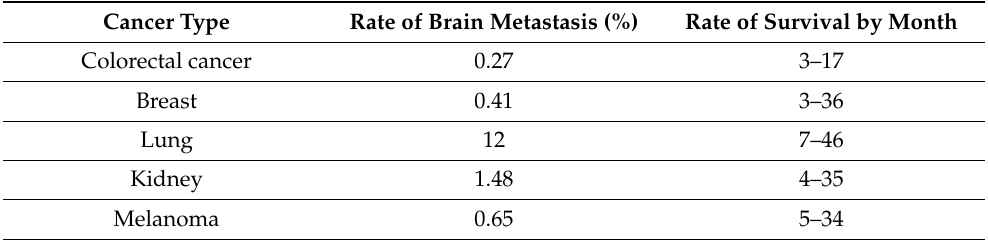
Table 1. Primary cancer types grouped by rate of brain metastasis and rate of survival (adopted from [2]). Cancer